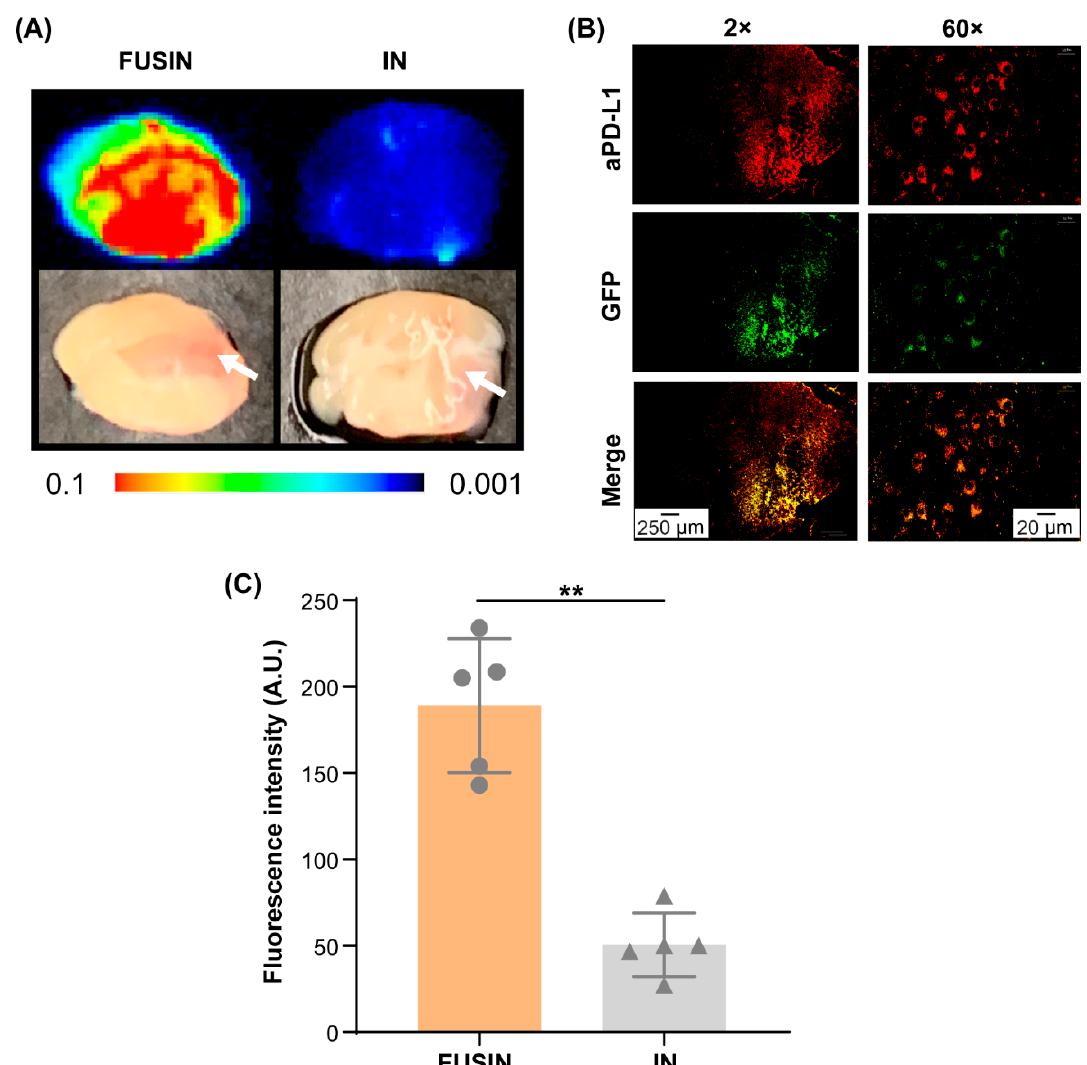
Figure 4. FUSIN delivery of 800CW-aPD-L1 to the brainstem glioma. ( A ) Fluorescence images of representative ex vivo mouse brainstem slices. The white arrow indicates the tumor location. ( B ) Spatial distribution of FUSIN-delivered 800CW-aPD-L1. Left panel: aPD-L1 distribution in a coronal section of the brainstem after FUSIN delivery imaged at 2×. Right panel: higher magnification view (60×) of the tumor showing the colocalization of aPD-L1 with the tumor cells. ( C ) Fluorescence quantification of the 800CW-aPD-L1 delivery efficiency to the brainstem glioma (** p < 0.01).